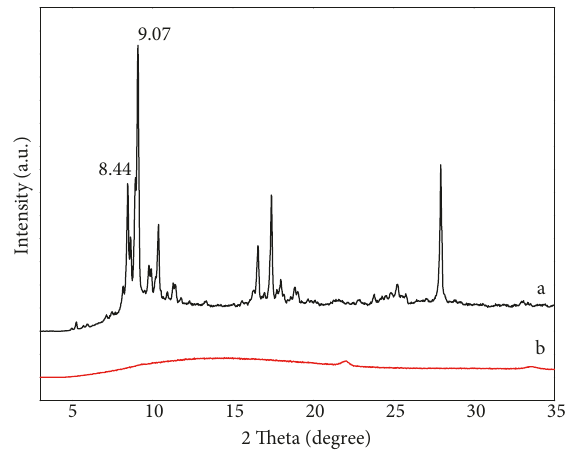
Figure 5: Powder X-ray diffraction for MIL-101 (a) and